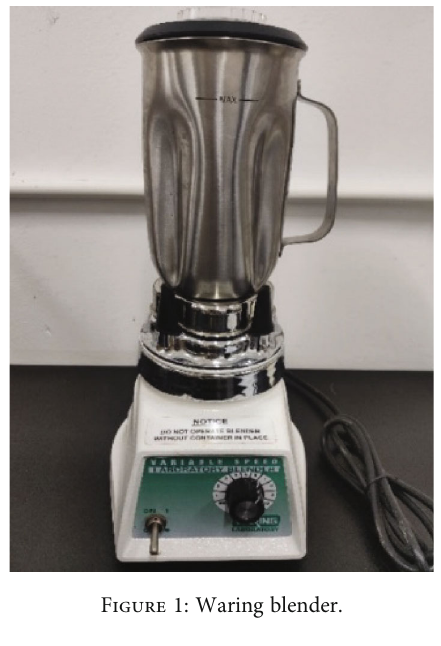
Figure 1: Waring